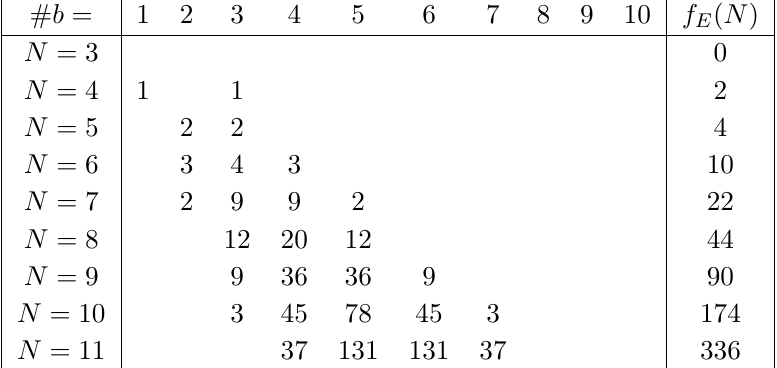
Table 10 . Counting of the entangled ground